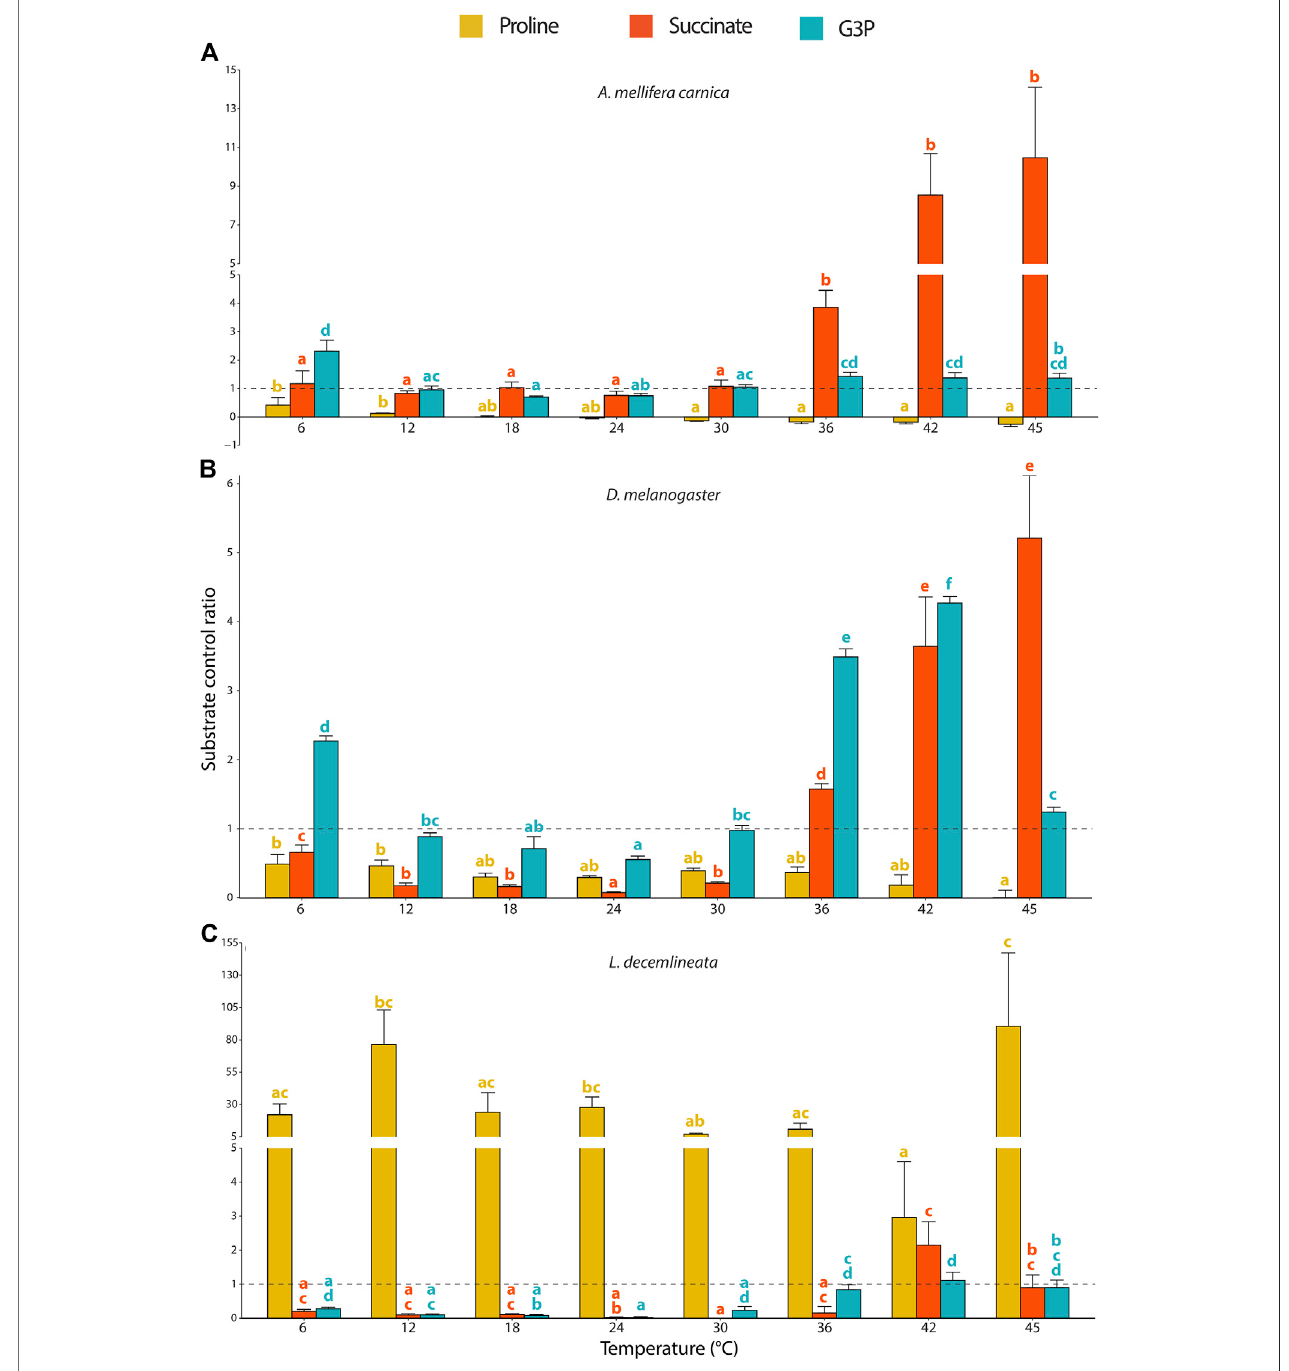
FIGURE3| Substratecontributionratio(SCR)forproline,succinateandG3Pcalculatedfrommitochondrialoxygenconsumptionratesmeasured inpermeabilized thoraces ofthe three insect species. (A) A. mellifera carnica ( n = 8 – 10), (B) D. melanogaster ( n = 5 – 10), and (C) L. decemlineata ( n =4 – 10). Substrate contribution ratios werecalculatedasSCR=(OCR2-OCR1)/OCR1where OCR1 represents theoxygenconsumption ratepriortotheinjection ofsubstrate x and OCR2 correspondstothe oxygen consumption rate after the injection of substrate x ; SCR = 1.0 is represented with a dashed line and indicates that OCR increased by 100% (doubled) after injection of a speci fi c substrate. Substrate contribution ratios are reported as mean ± s.e.m. and were compared within species for each substrate and between assay temperatures using a one-way ANOVA followed by a HSD (Honest Signi fi cant Difference) Tukey ’ s test. Dissimilar letters indicate signi fi cant differences between assay temperatures (yellow for proline, red for succinate and blue for G3P) for each species. In honeybees (proline) and beetles (succinate and G3P), one-way ANOVA conditions were not met, and a non-parametric test (Kruskall-Wallis) followed by a Dunn ’ s test were performed.